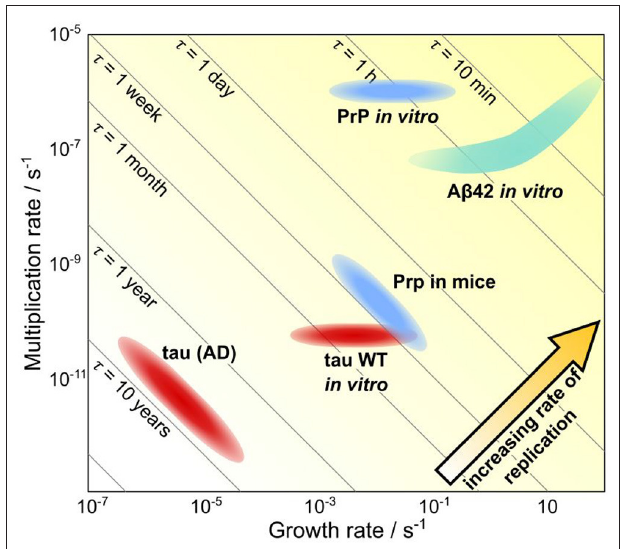
FIGURE 6 | Quantification of timescales of aggregation across systems. A plot showing the growth rate versus the multiplication rate, for a number of proteins, using either rates determined in vivo or rates determined in vitro and extrapolated to in vivo concentrations. Along the diagonal lines, the doubling time is unchanged, thus going from the bottom left hand to the top right hand corner the rate of replication increases. Notably, the same proteins tend to aggregate orders of magnitude slower in vivo than they do in vitro , highlighting the ability of living systems to prevent aggregation. Adapted from Meisl et al.